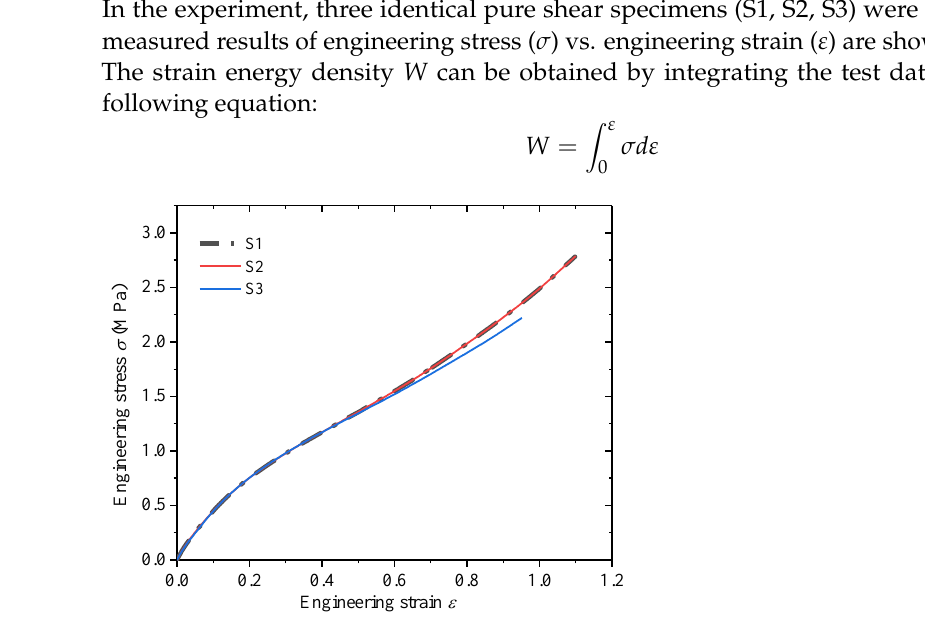
Figure 2. The engineering stress versus engineering strain.